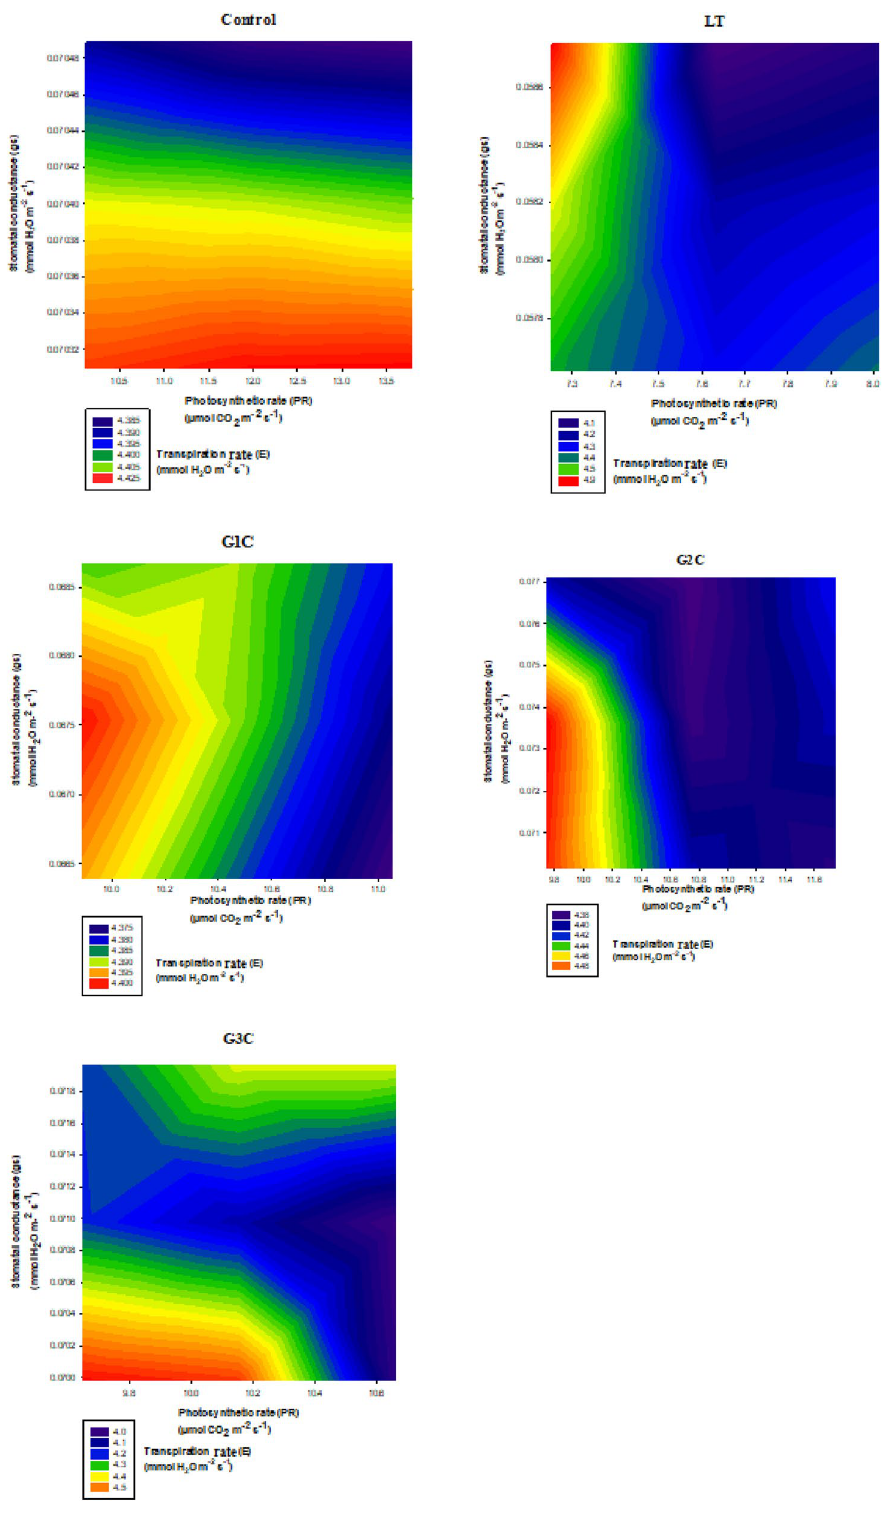
Figure 5. 2D contour plots showing relationship between stomatal conductance, photosynthetic rate and transpiration rate under low temperature stress in accordance with varying concentration of GSH. Control (Con): 25/18 °C + 0 mM GSH, Low temperature stress (LT): 10/3 °C + 0 mM GSH, G1C: 10/3 °C + 0.5 mM GSH, G2C: 10/3 °C + 1 mM GSH, G3C: 10/3 °C + 2 mM